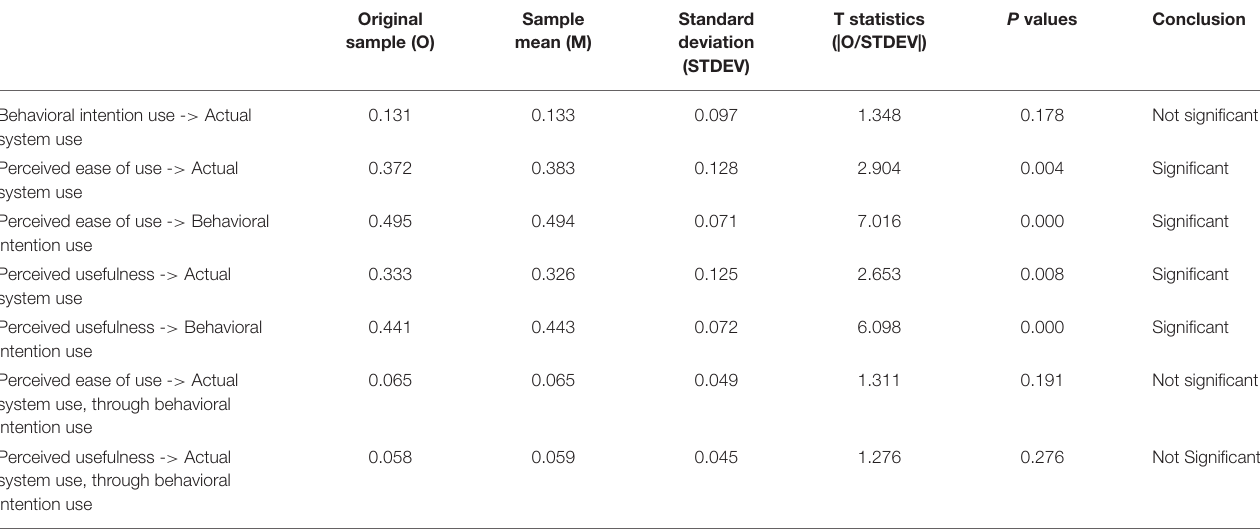
TABLE 5 | The structural equation modeling results.